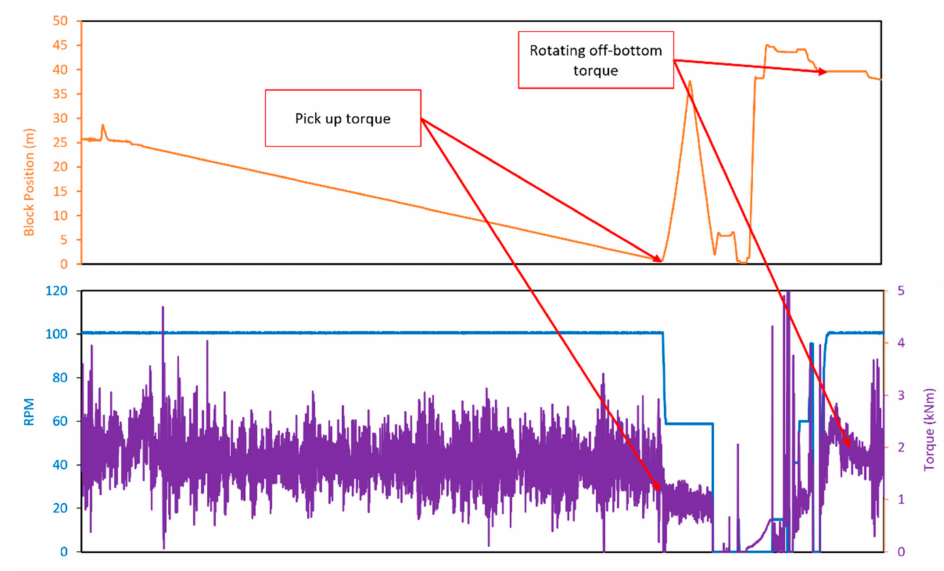
Figure 5. An example of selected pick-up off-bottom and rotating off-bottom torque used in off- bottom torque